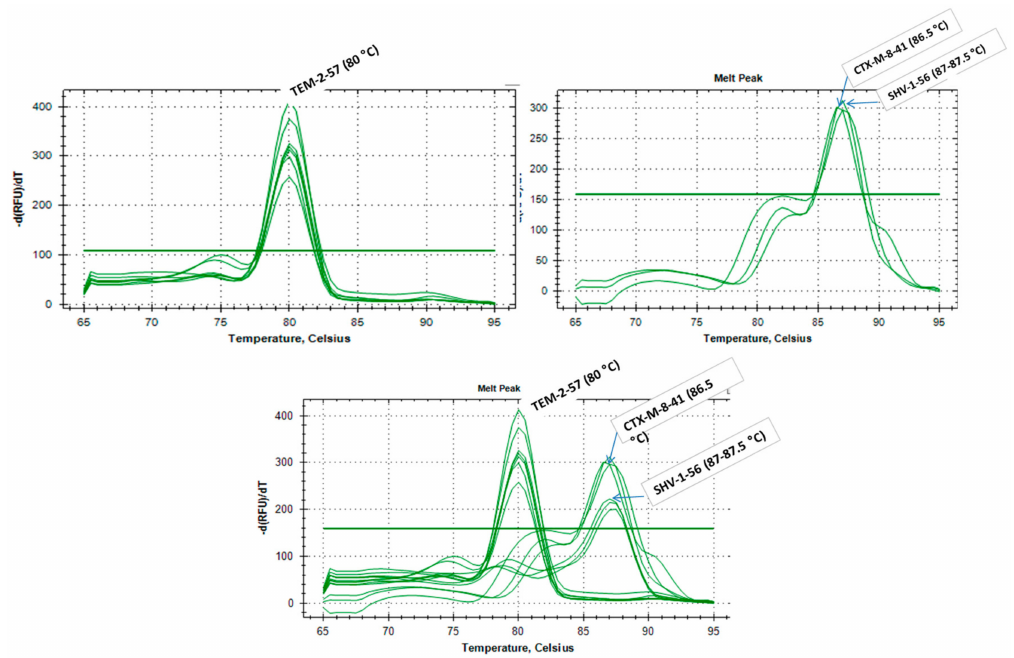
Figure 3. Illustrative plot showing detection of CTX-M, SHV and TEM through HRM analysis of E. coli isolates ( A ) simplex HRM for seven isolates with TEM-2-57, ( B ) duplex HRM for two isolates with SHV-1-56 and one with CTX-M-8-41, ( C ) triplex HRM for seven isolates with TEM-2-57, five isolates with SHV-1-56 and one isolate with CTX-M-8-41. Melting temperatures (Tm) are shown for each HRM target.